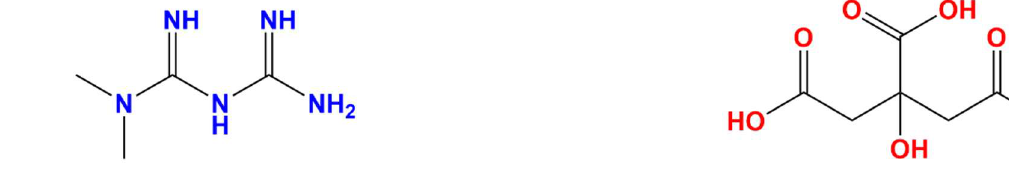
Figure 1. Chemical formula of metformin (MTF) and citric acid (CIT).